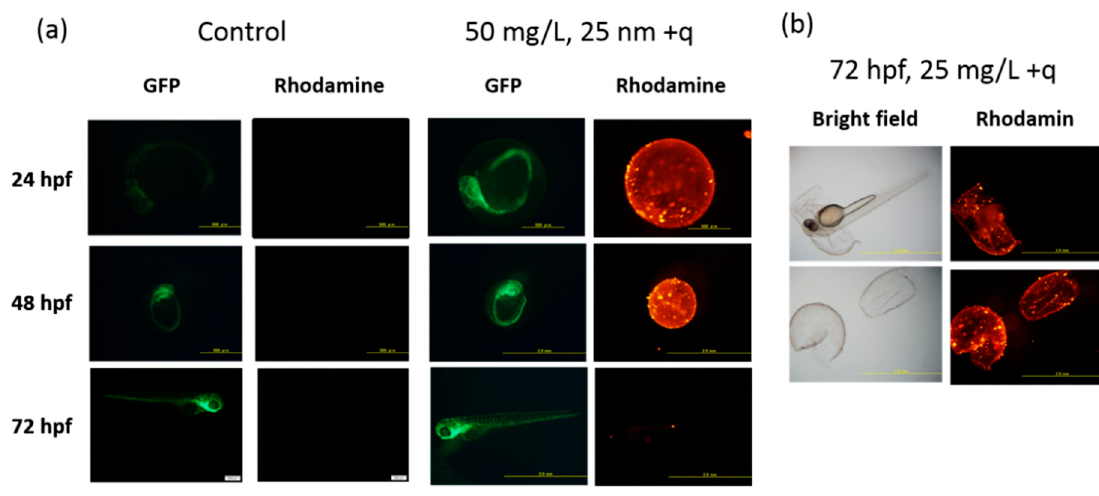
Figure 4. Representative fluorescence microscopy images of zebrafish embryos. ( a ) Images of embryos exposed to 0 (control) or 50 mg/L of positively charged SiO 2 NPs (25 nm) at 24, 48, and 72 hpf and ( b ) embryos exposed to 25 mg/L of positively charged SiO 2 NPs (25 nm) at 72 hpf.